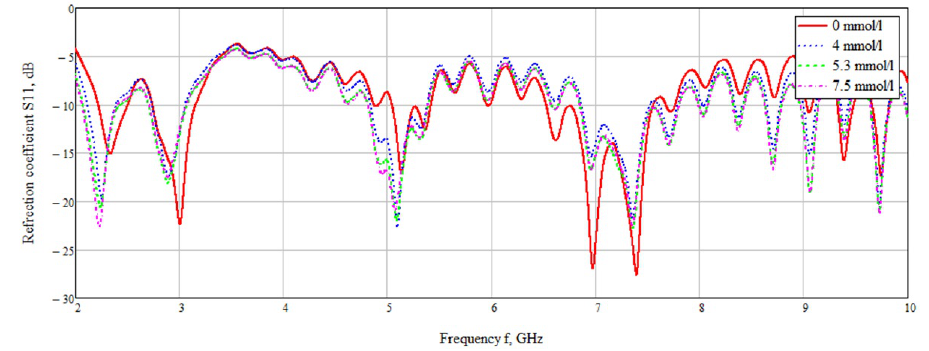
Figure 13. Frequency dependence of the reflected signal from the unidirectional probe for various glucose concentrations. Frequency range 2–10